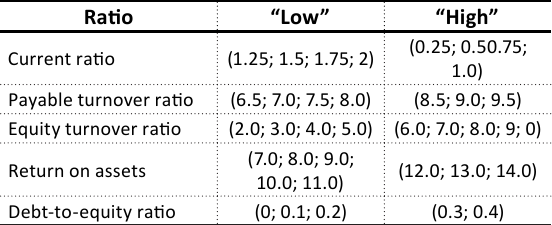
Table 2. Classification of financial indicators